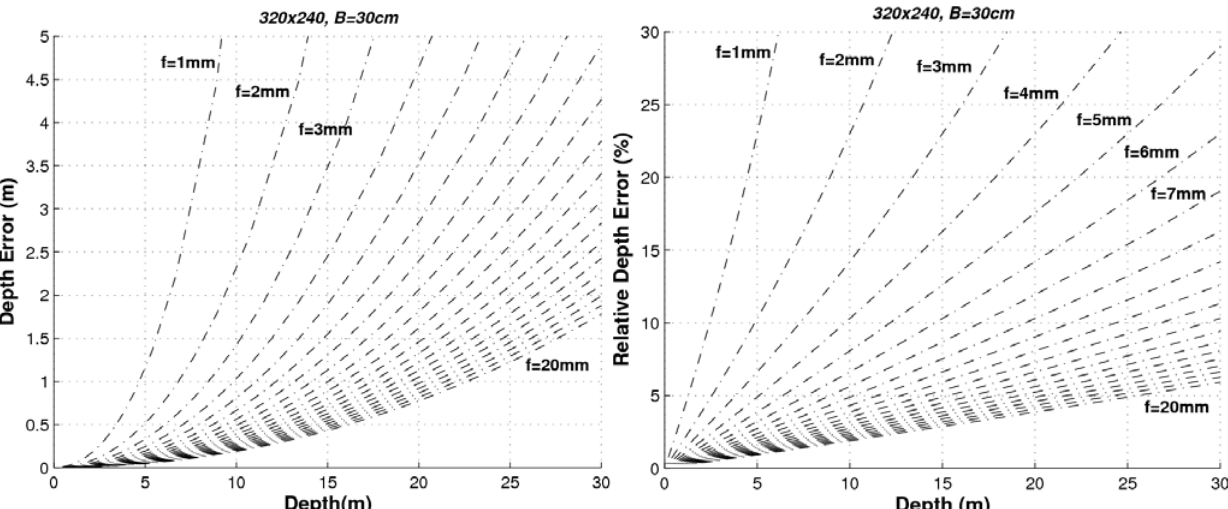
Figure 5. Absolute and relative depth estimation errors for a stereo sensor with and image size of 320 × 240 px, for different focal lengths.